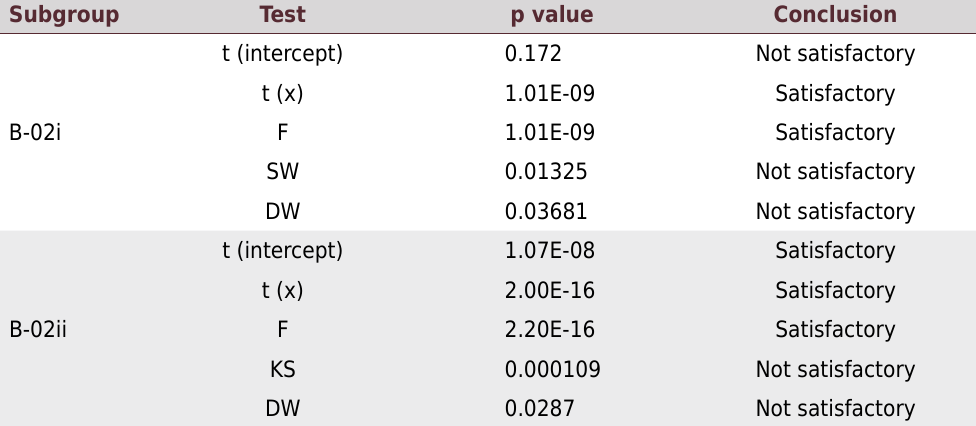
Table 4. Summary of the results of the statistical tests for the correlations evaluated in B-02 Subgroup Test p